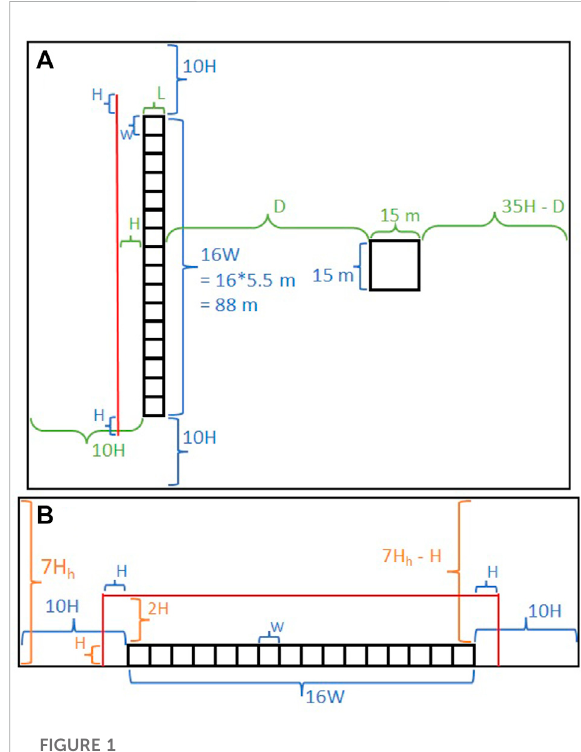
view and (B) is a front view looking along the fl ow into the vegetationfence. H:fence height (5.5 m), W: width of an individual tree (5.5 m), L: length of an individual tree (5.5 m), H h : house height (9.1 m), D: distance between the house and the fence.